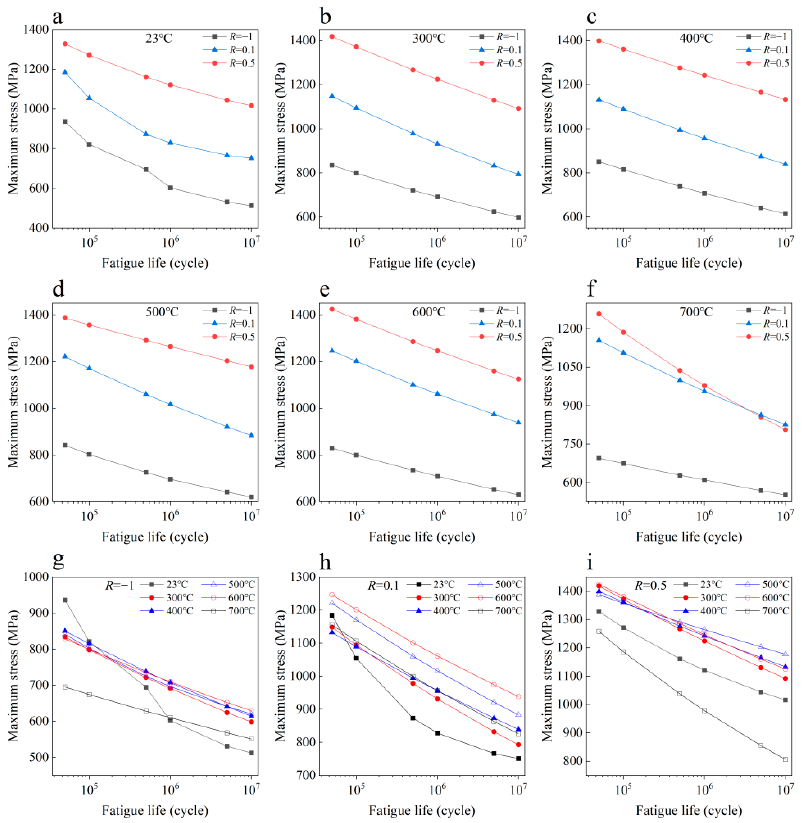
Figure 1. S ‐ N data of nickel ‐ based superalloy at different temperatures and stress ratios: ( a – f ) Dif ‐ Figure 1. S-N data of nickel-based superalloy at different temperatures and stress ratios: ( a – f ) Different ferent stress ratios at 23 °C, 300 °C, 400 °C, 500 °C, 600 °C, 700 °C, respectively; ( g – i ) Different tem ‐ stress ratios at 23 ◦ C, 300 ◦ C, 400 ◦ C, 500 ◦ C, 600 ◦ C, 700 ◦ C, respectively; ( g – i ) Different temperatures peratures at R = − 1, R = 0.1 and R = 0.5, respectively. at R = − 1, R = 0.1 and R = 0.5,